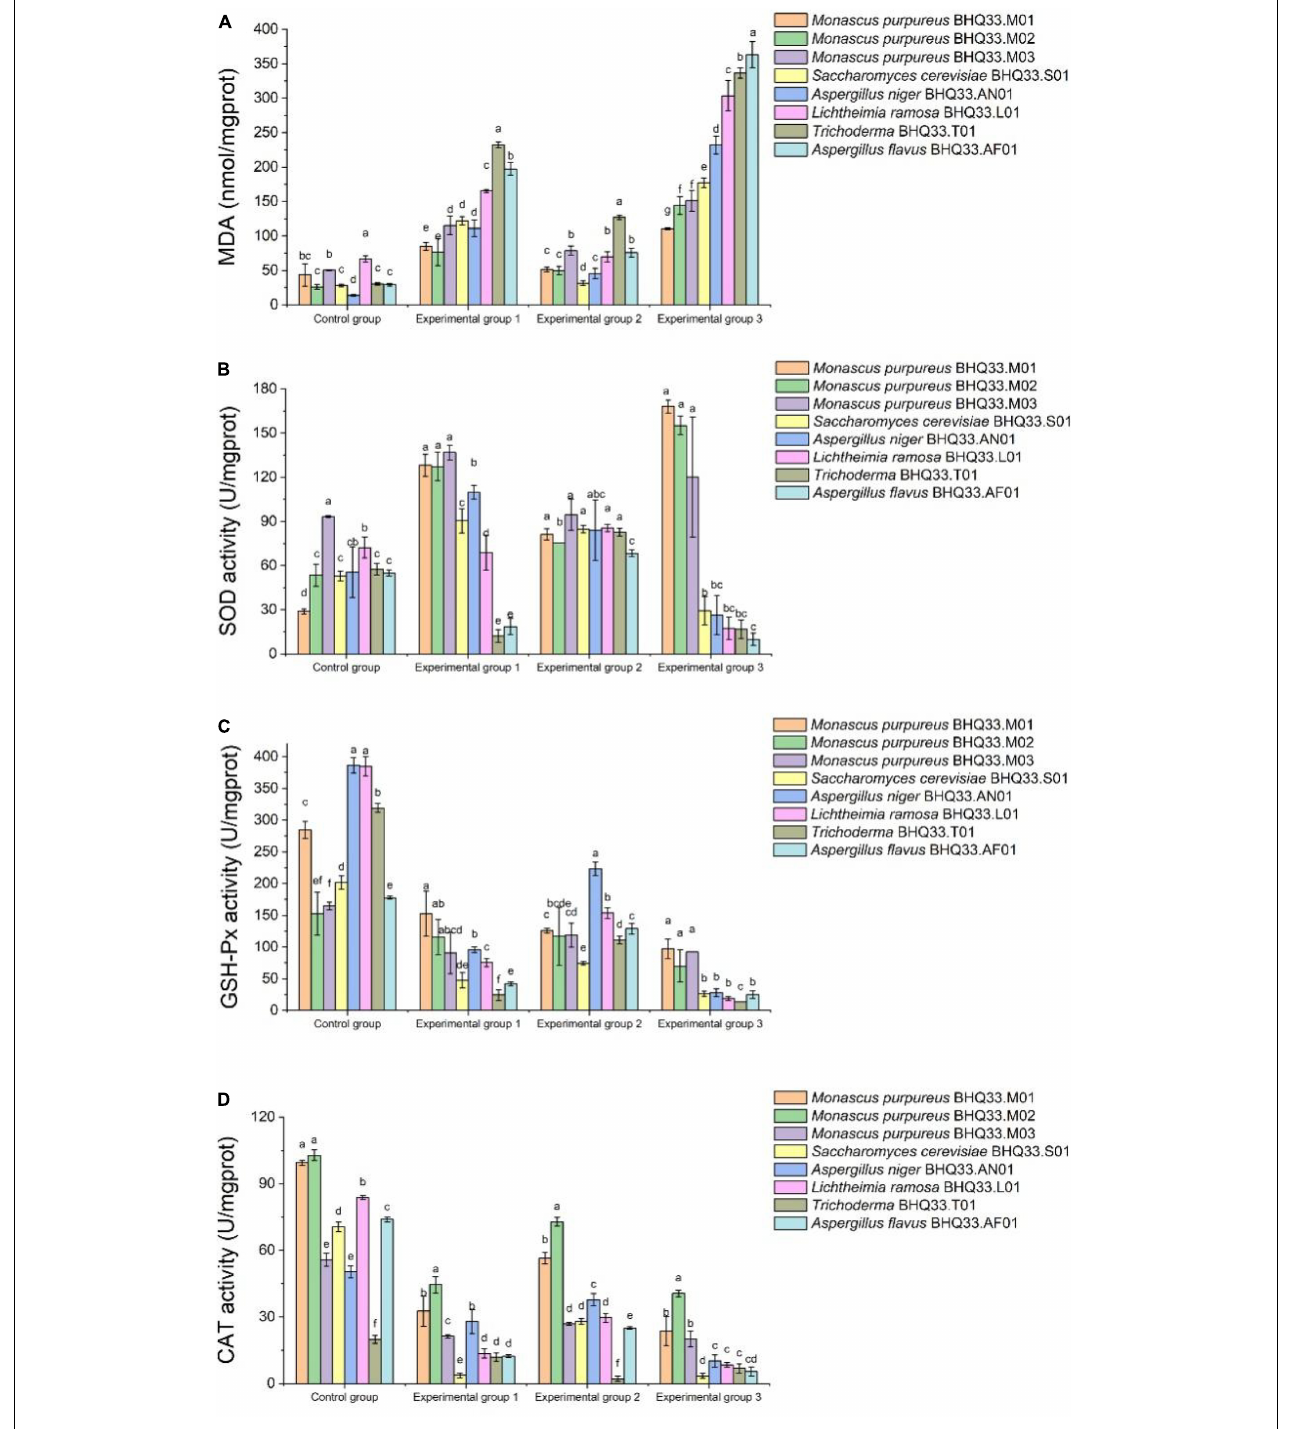
FIGURE 7 | Intracellular antioxidant capacity of different fungi isolated from Hongqu BHQ33 under lactic and ethanol stress. Different fungi isolated from Hongqu BHQ33 were cultured in medium containing different concentrations of lactic acid and ethanol at 30 ◦ C and 200 r/min for 24 h, and intracellular metabolites malondialdehyde (MDA) (A) , total superoxide dismutase (SOD) (B) , total glutathione peroxidase (GSH-Px) (C) , and catalase (CAT), (D) were detected. In the initial medium, control group was basal medium without lactate and ethanol, experimental group 1 was supplemented with 3.98% (v/v) lactic acid in basal medium, experimental group 2 with 6.24% (v/v) ethanol, and experimental group 3 with both 3.98% (v/v) lactic acid and 6.24% (v/v) ethanol. Error bars indicate the standard deviation (SD) of the means ( n = 3), and different lowercase letters represent significant differences in the detection indexes of fungi isolated from Hongqu BHQ33 under the same treatment conditions ( p <